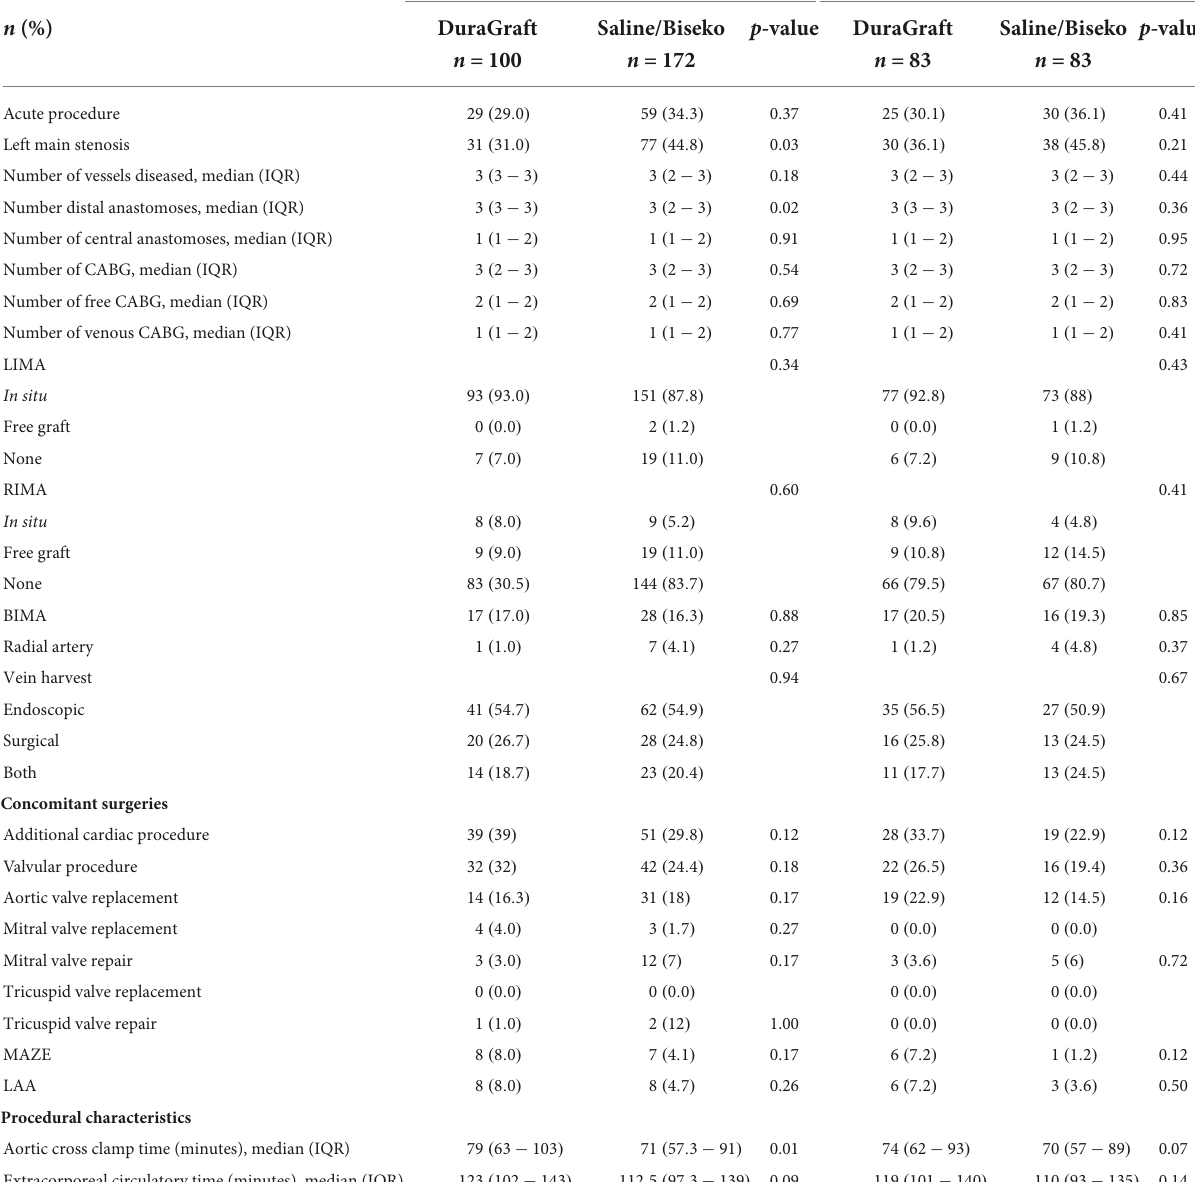
TABLE 2 Procedural characteristics and concomitant